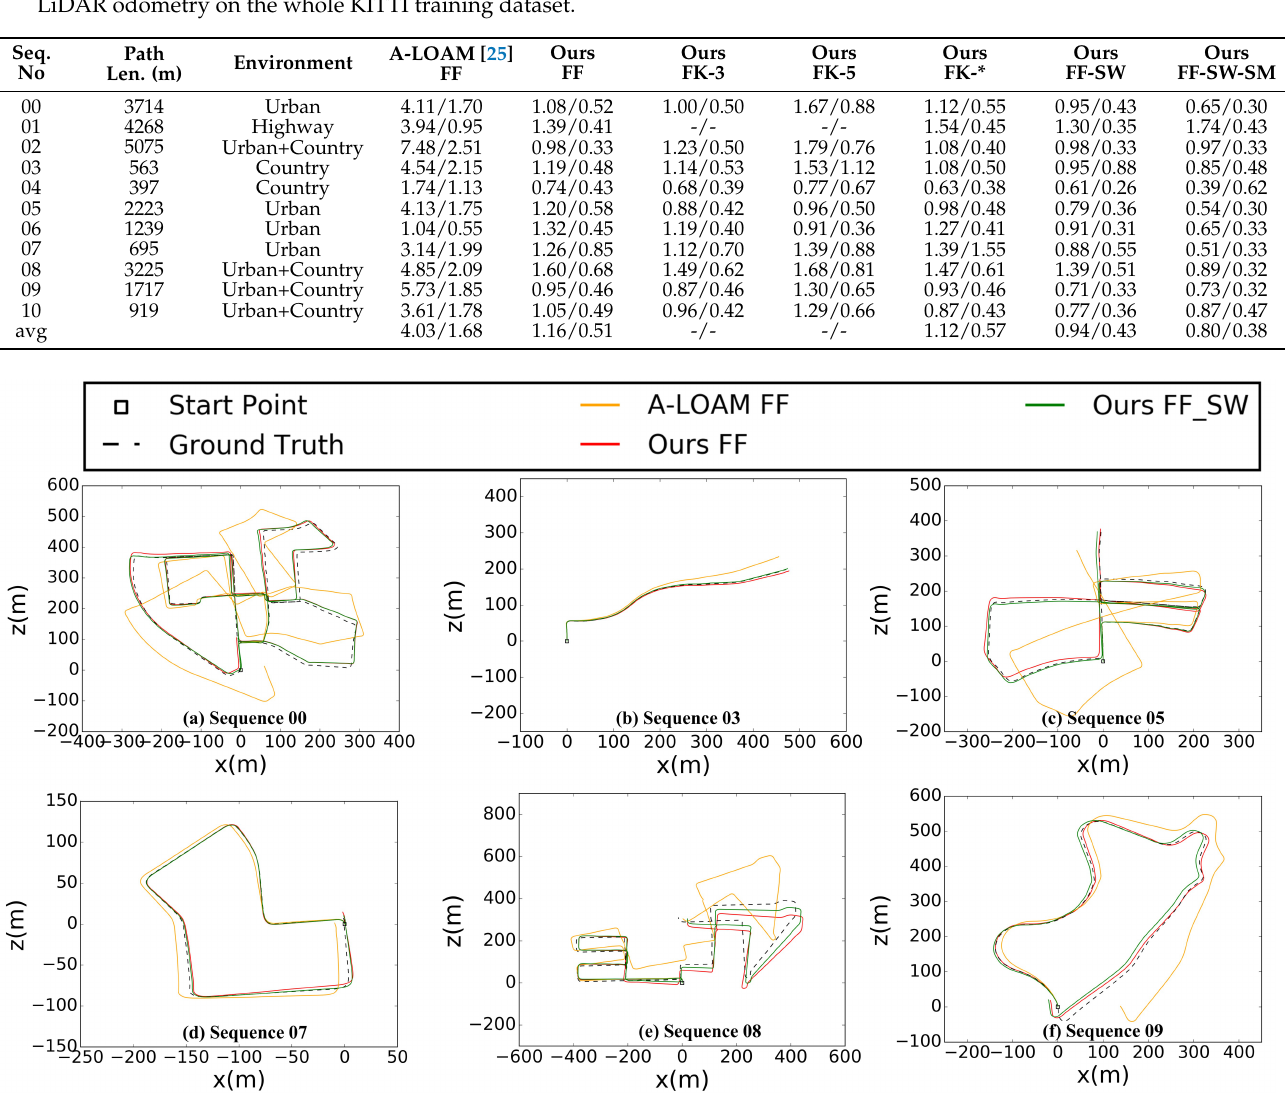
Figure 21. Our motion tracking trajectories on several representative KITTI training dataset, with results by our direct frame-to-frame visual LiDAR odometry (Ours FF) , the direct visual LiDAR odometry with slide window optimization module (Ours FF_SW) and LiDAR scan matching based frame-to-frame tracking odometry (A-LOAM FF) comparing with the ground truth (Ground Truth) trajectory